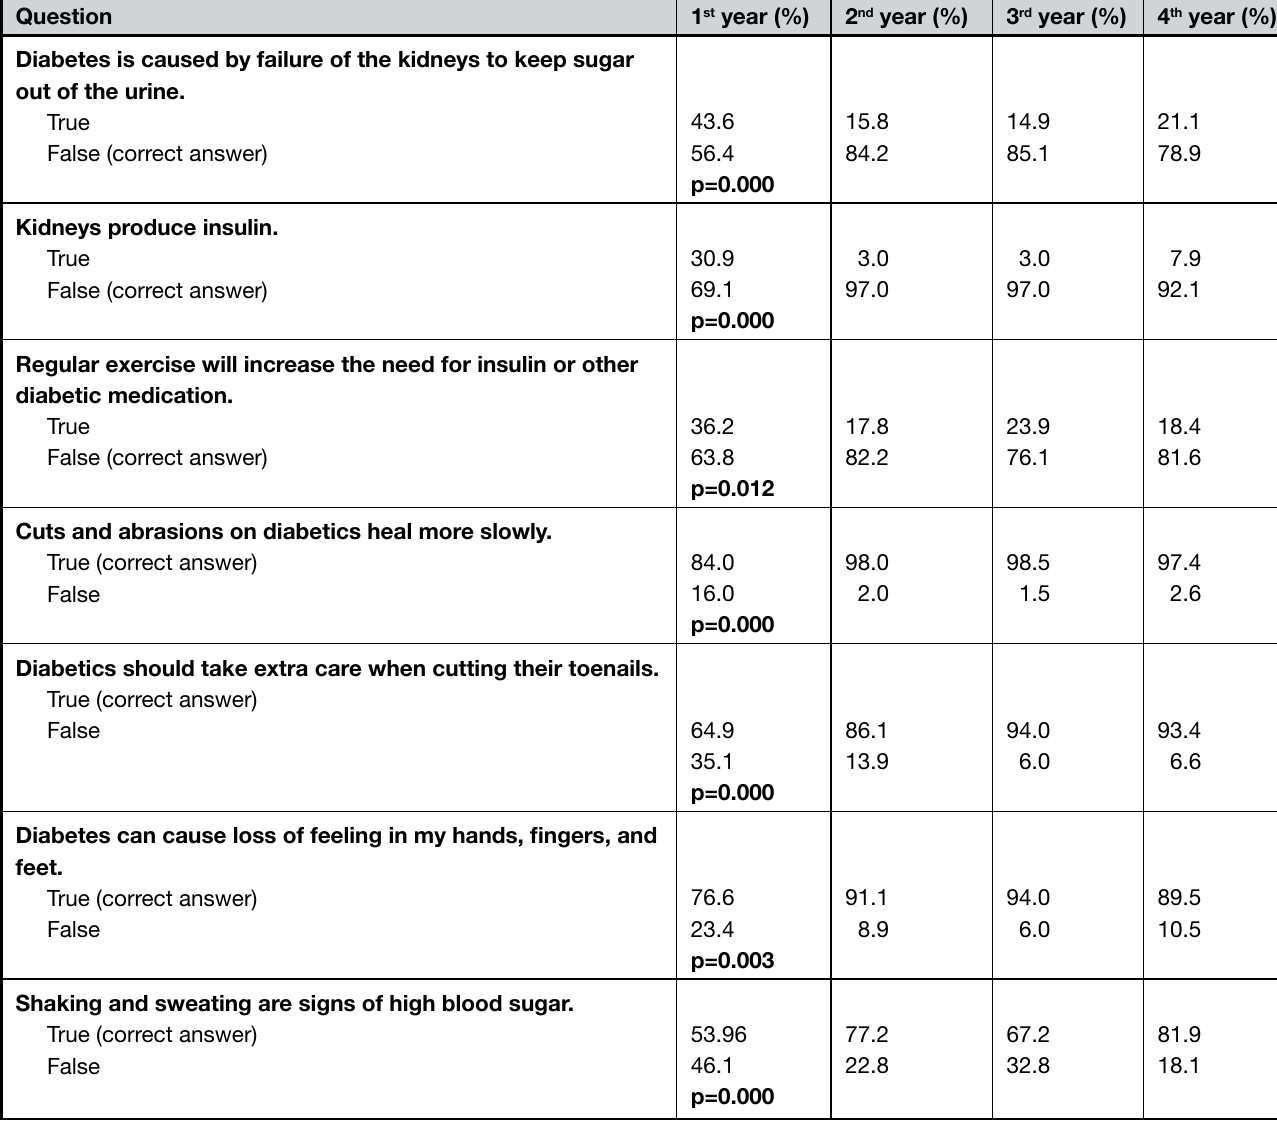
Table 3: Distribution of knowledge of DM risk factors Risk